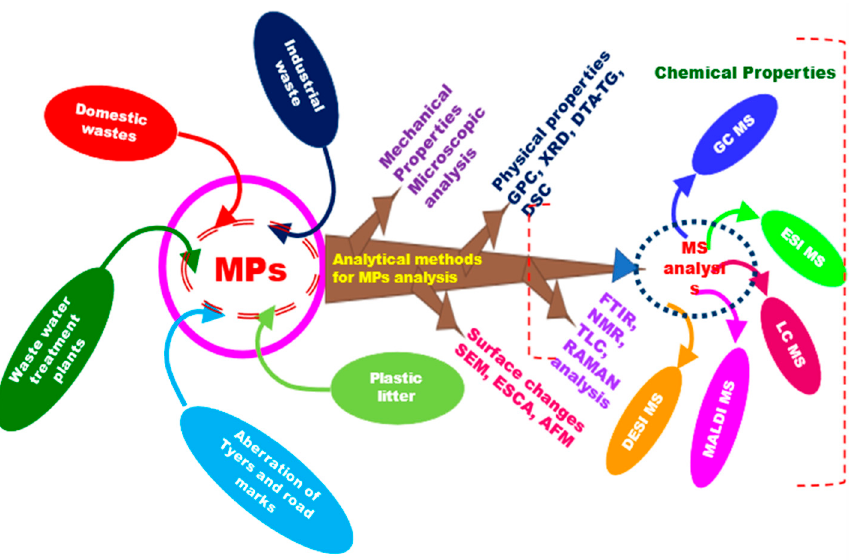
Figure 2. Overview of analytical methods that contribute to MPs detection in the Figure 2 . Overview of analytical methods that contribute to MPs detection in the environment.